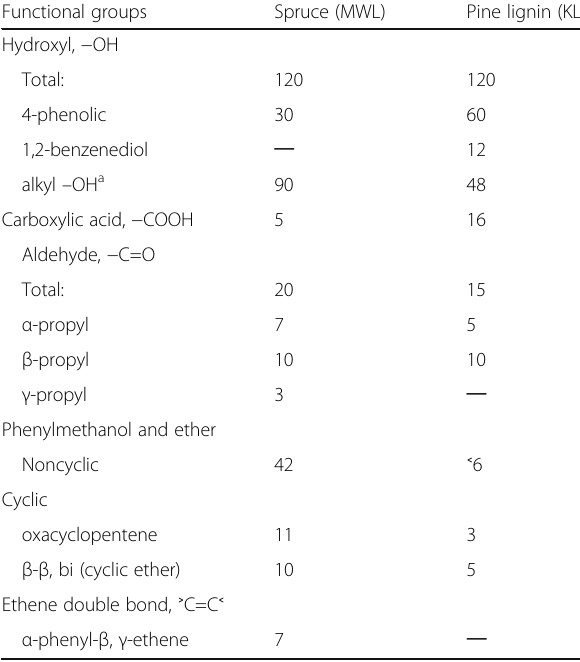
Table 2 Functional groups found in 100, C 9 repeat units of lignin